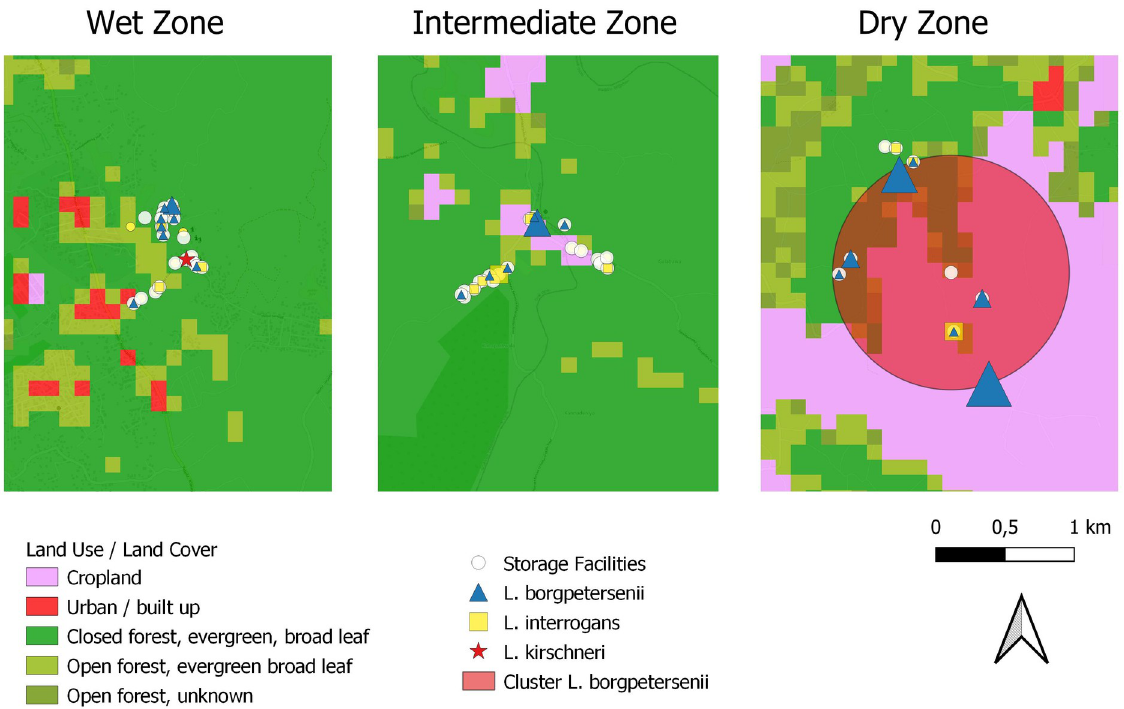
Fig 3. Occurrence of pathogenic Leptospira spp. infection in small mammal species at the three climate zones in Sri Lanka. Blue triangles indicate occurrence of L . borgpetersenii , yellow squares occurrence of L . interrogans and the red star the occurrence of L . kirschneri . The size of triangles and squares is proportional to the number of infected animals within storage facility. The large red circle indicates a cluster of increased risk of L . borgpetersenii infection. Land use and land cover base layer obtained from https://land.copernicus.eu/global/products/lc.